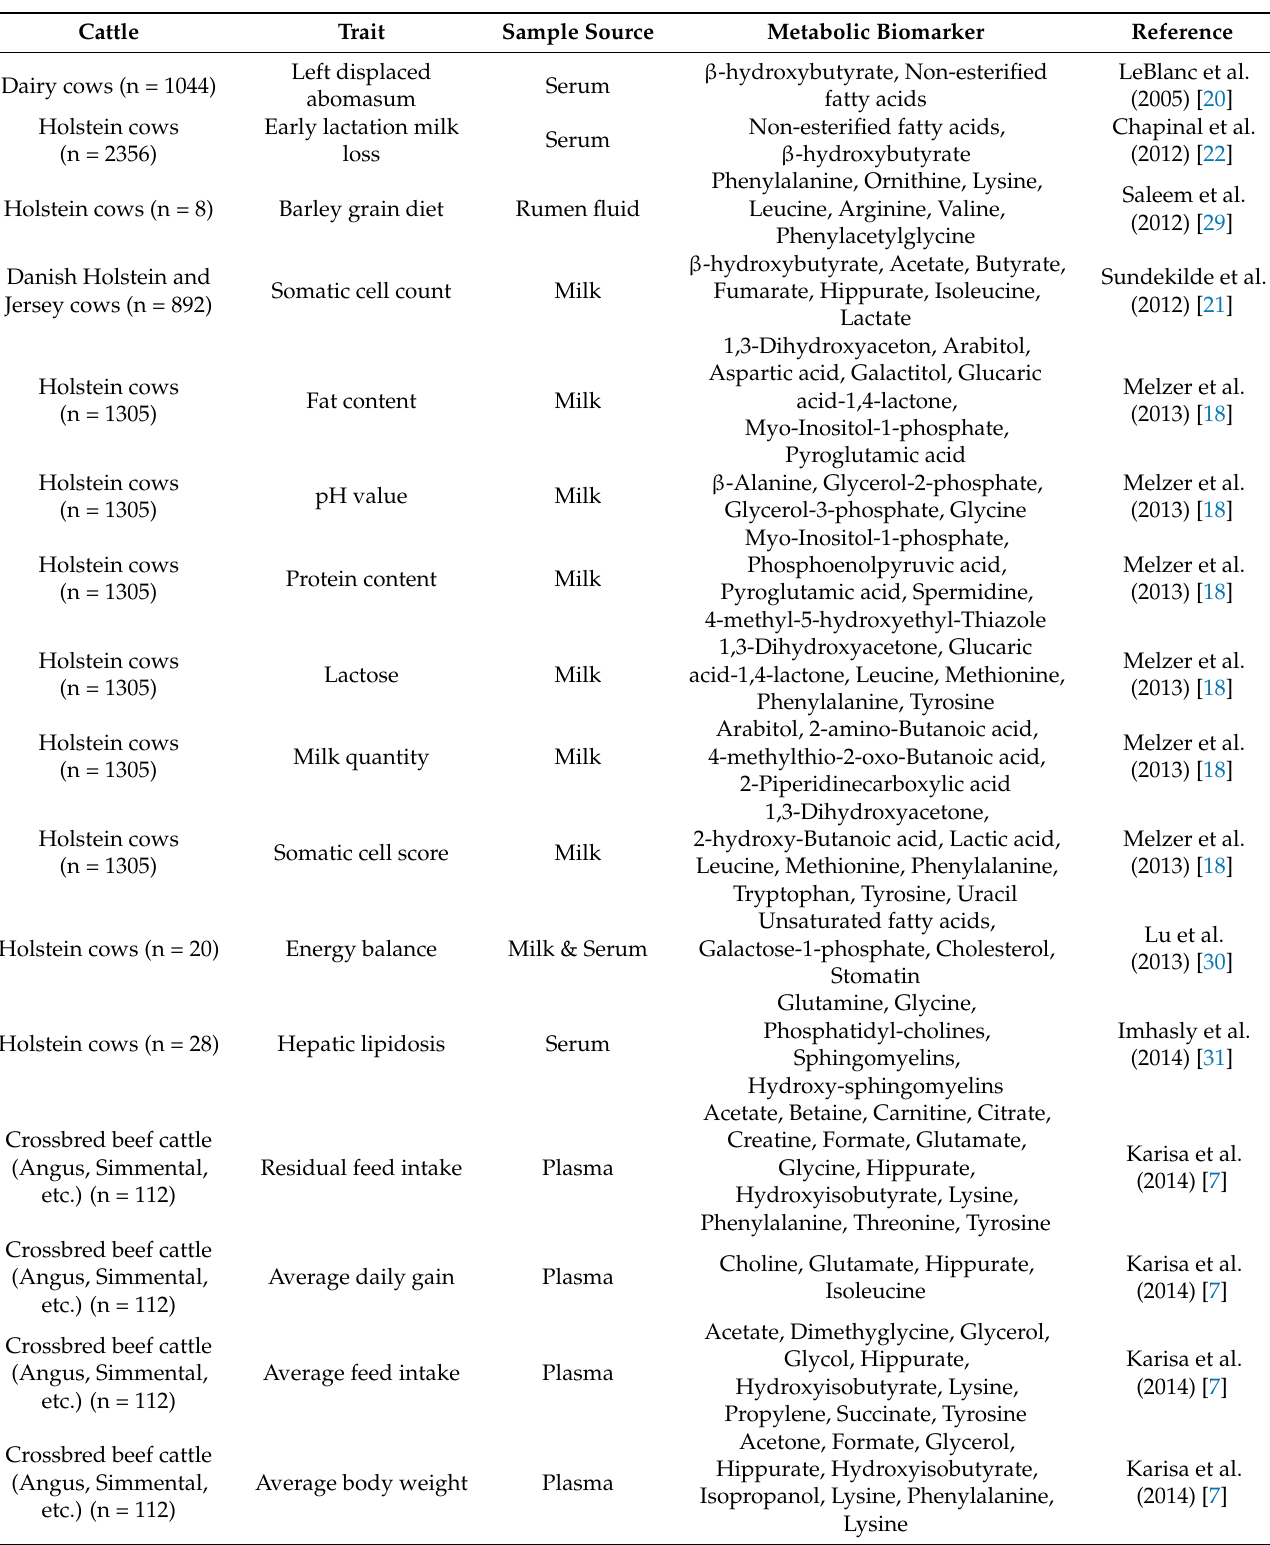
Table 1. Summary of candidate metabolic biomarkers associated with production and health traits in cattle identified by the previous